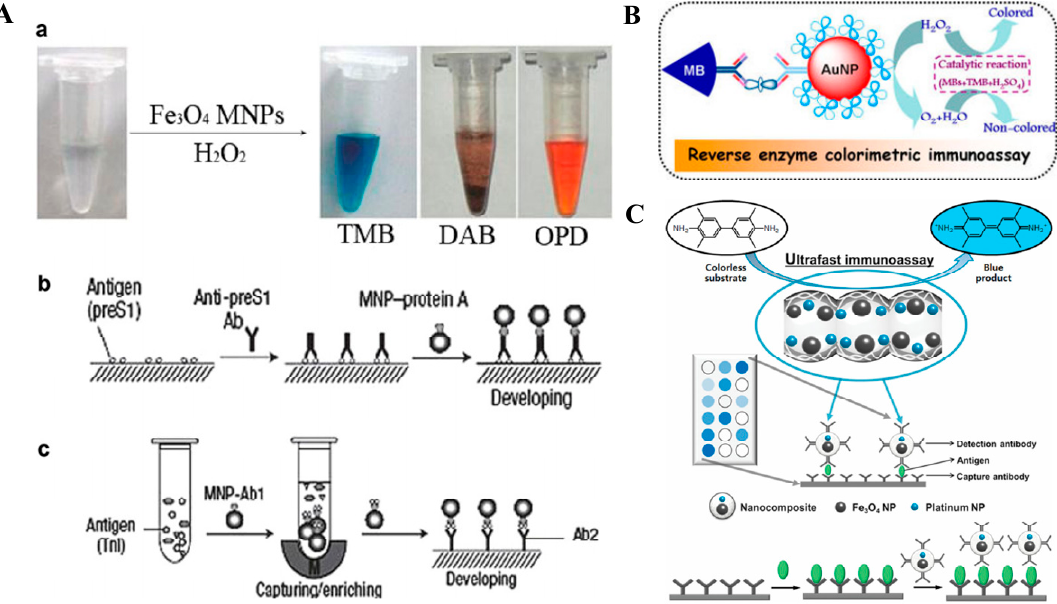
Figure 4. ( A ) The peroxidase-like activity of magnetic nanoparticles (MNPs) and two immunoassays based on the peroxidase activity of MNPs. Reproduced with permission from [62]. Copyright The Nature Publishing Group, 2007. ( B ) Magnetocontrolled enzyme-mediated reverse colorimetric immunosensing strategy. Reproduced with permission from [64]. Copyright American Chemical Society, 2013. ( C ) Immunoassay based on a nanocomposite entrapping both MNPs and Pt NPs in mesoporous carbon. Reproduced with permission from [65]. Copyright John Wiley and Sons, 2014.